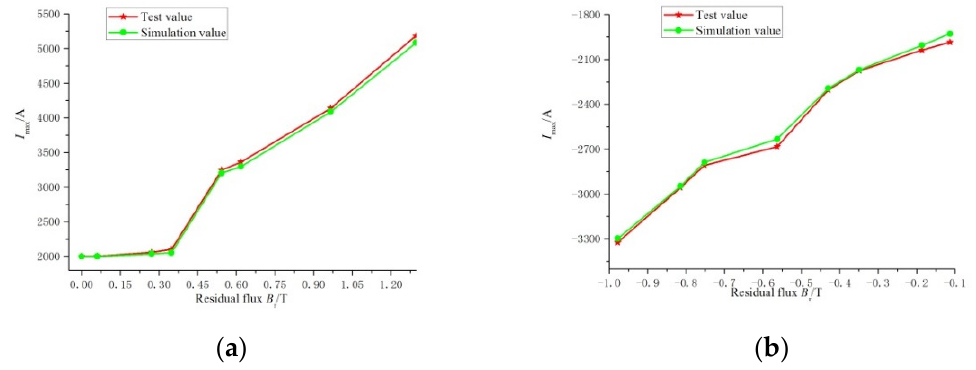
Figure 21. Maximum inrush current under different residual flux: ( a ) switching angle θ = 0°; ( b ) switching angle θ = 170°.